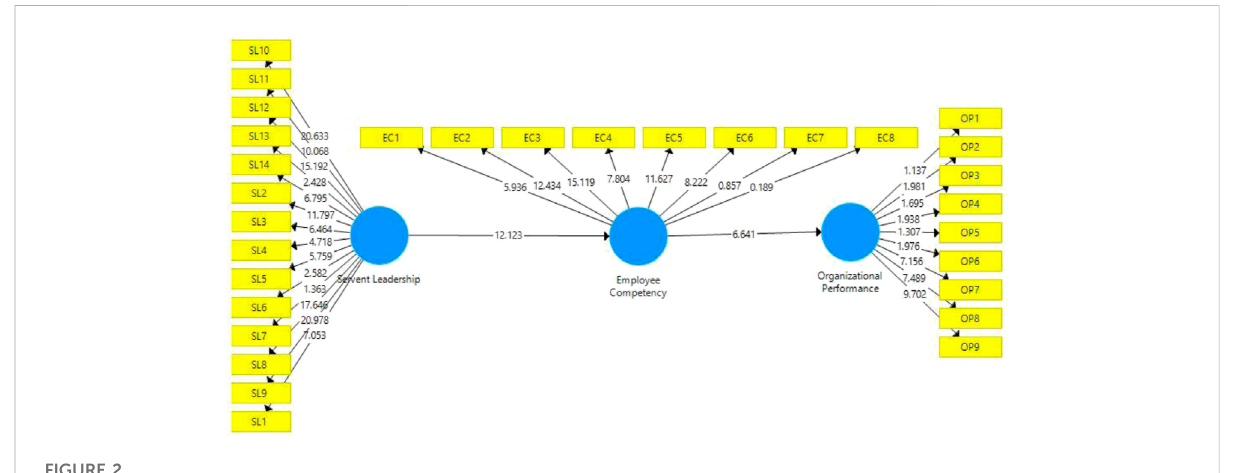
FIGURE 2 Assessment of the structural